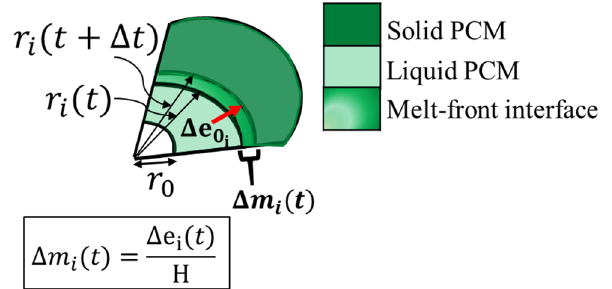
Figure 7. Computed melt ‐ front location at next time ‐ step.